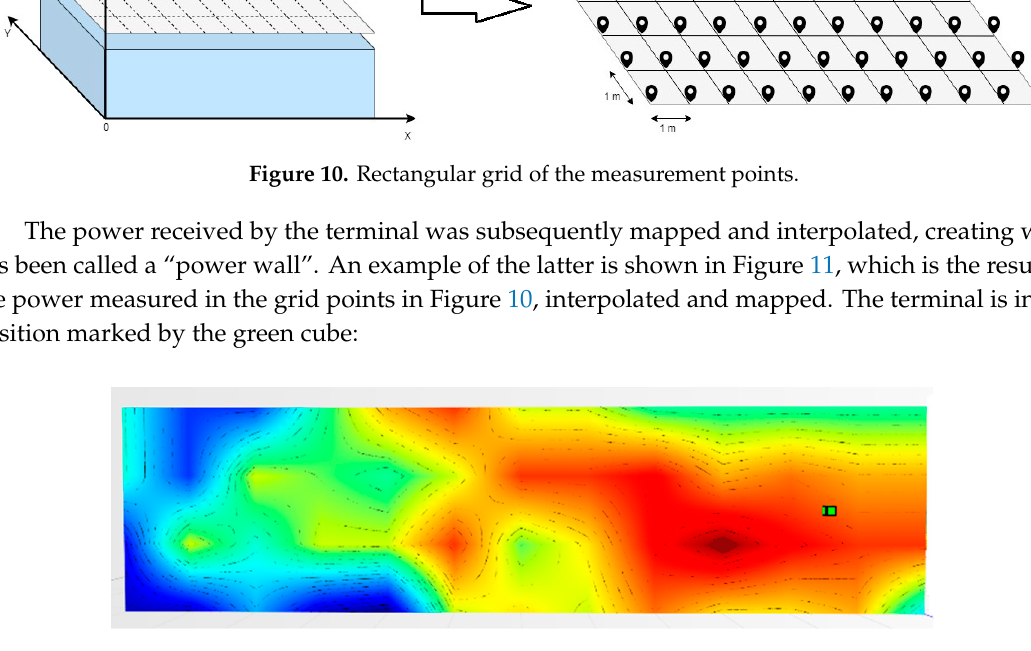
Figure 11. “Power wall” of the values measured in the grid points.